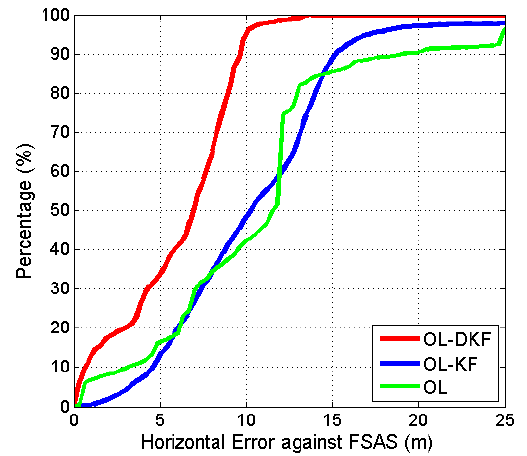
Figure 30. Position error probability of roads in the city canyon test.